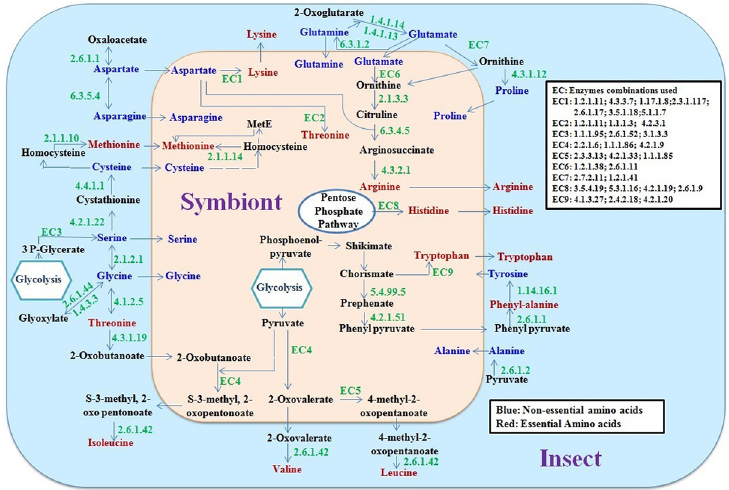
Fig 7. A hypothetical amino acid biosynthetic pathway in whitefly. Pinkish and sky-blue circles represent the symbiont and the insect, respectively. The enzymes are denoted as enzyme commission number (x.x.x.x) in green letters. EC means the enzyme combinations used at particular